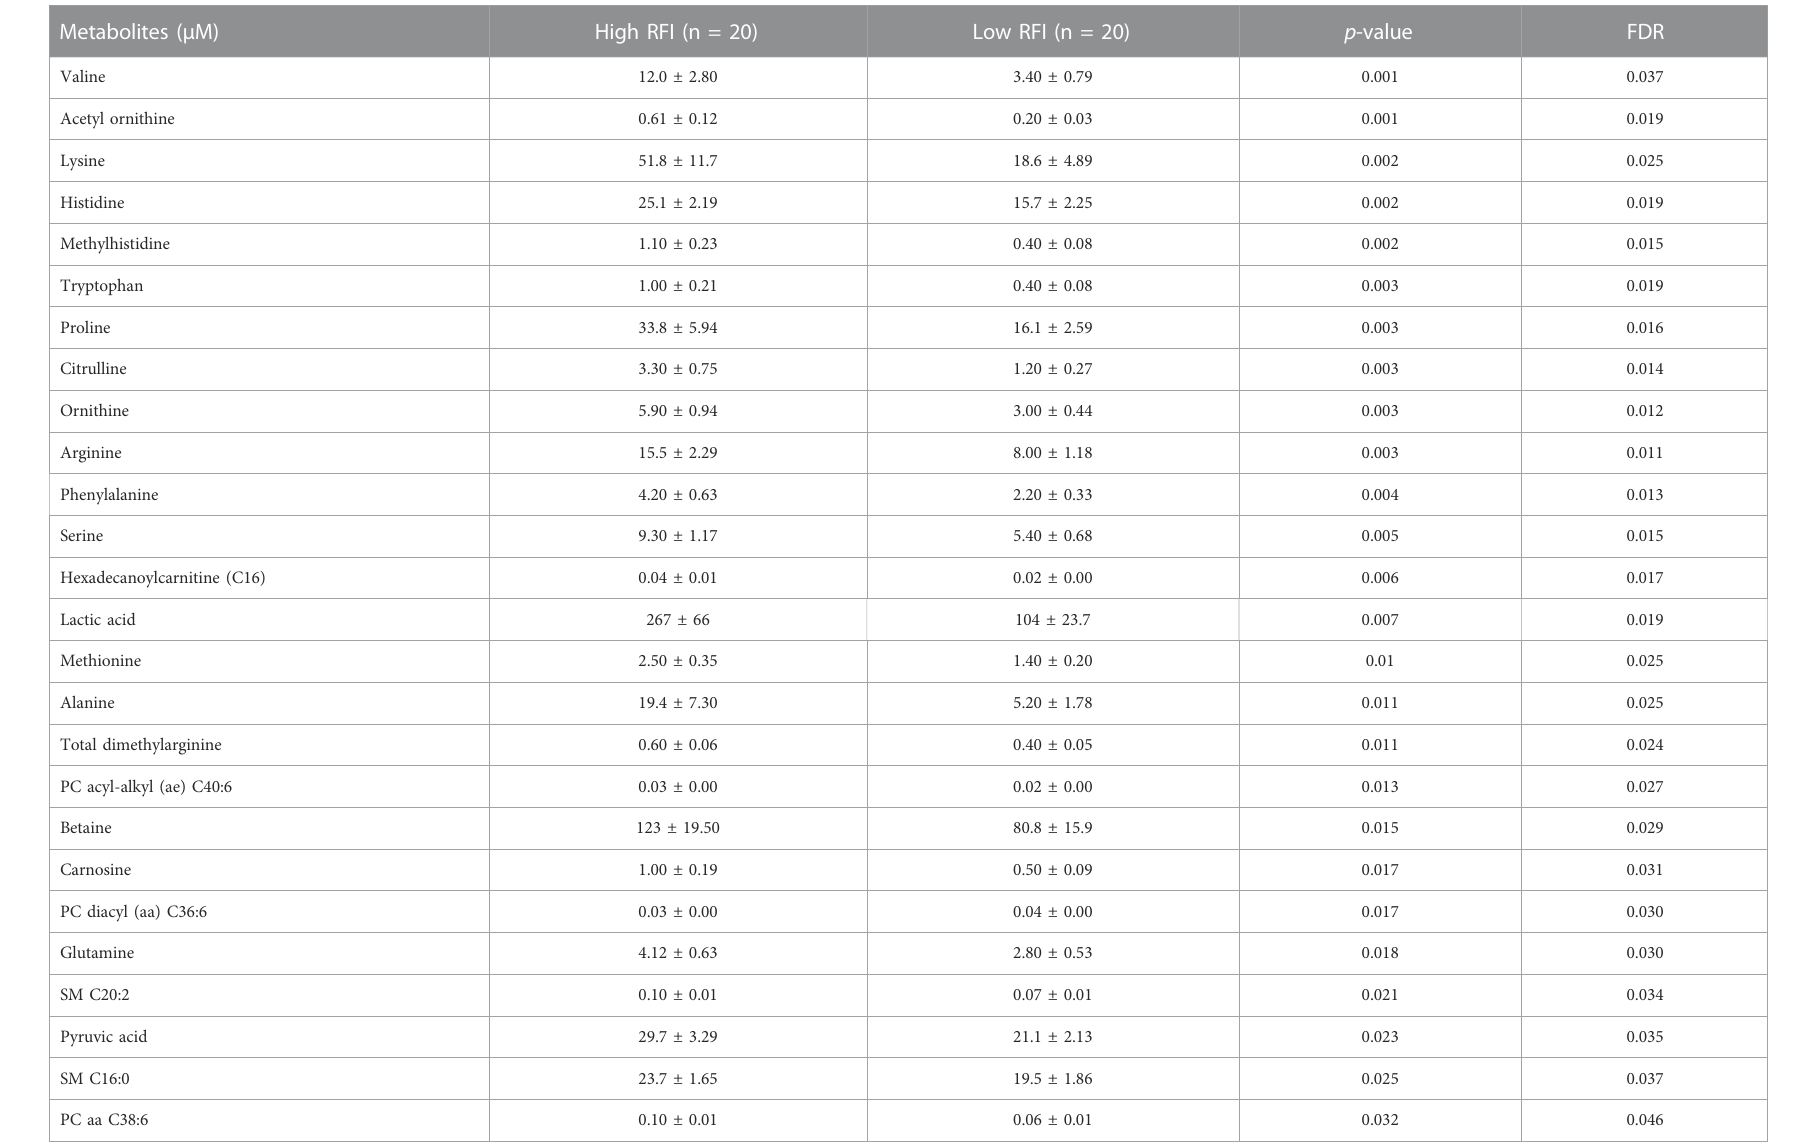
TABLE 4 List of milk metabolites with altered concentrations in the high vs. low RFI comparisons at late lactation stage. The metabolite concentrations were described in least square means (LSM) and corresponding standard error of mean (SEM) in each group with p -values and false discovery rate